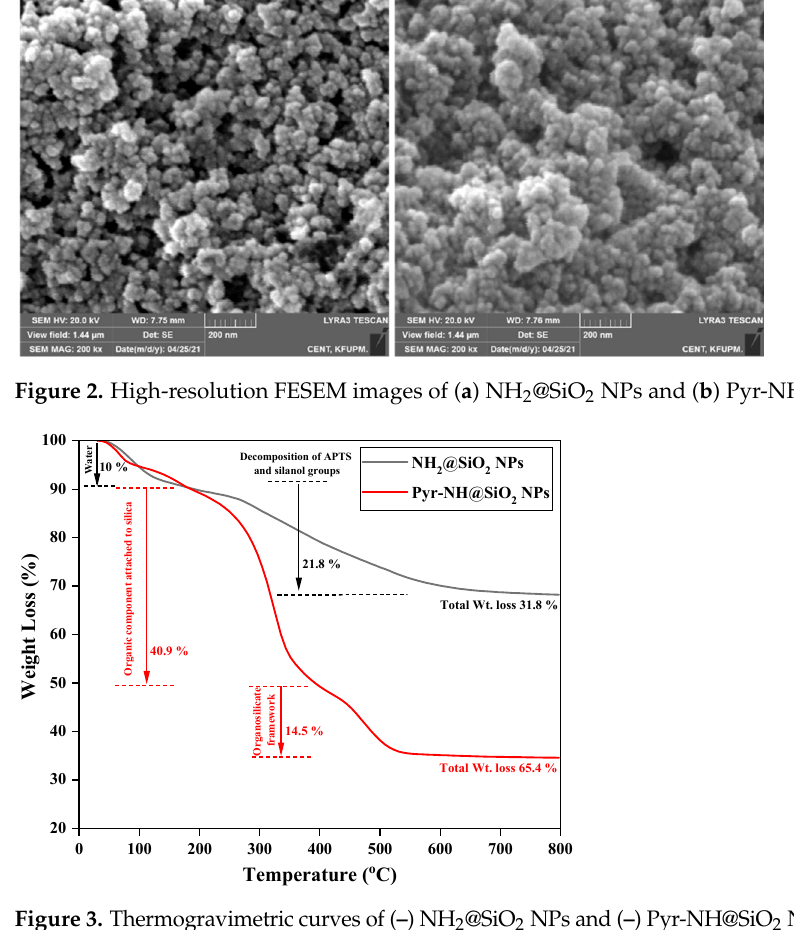
Figure 3. Thermogravimetric curves of ( – ) NH 2 @SiO 2 NPs and ( – ) Pyr-NH@SiO 2 NPs show the ther- mal decomposition of organic components and organosilicate frameworks attached to silica nano- particles.